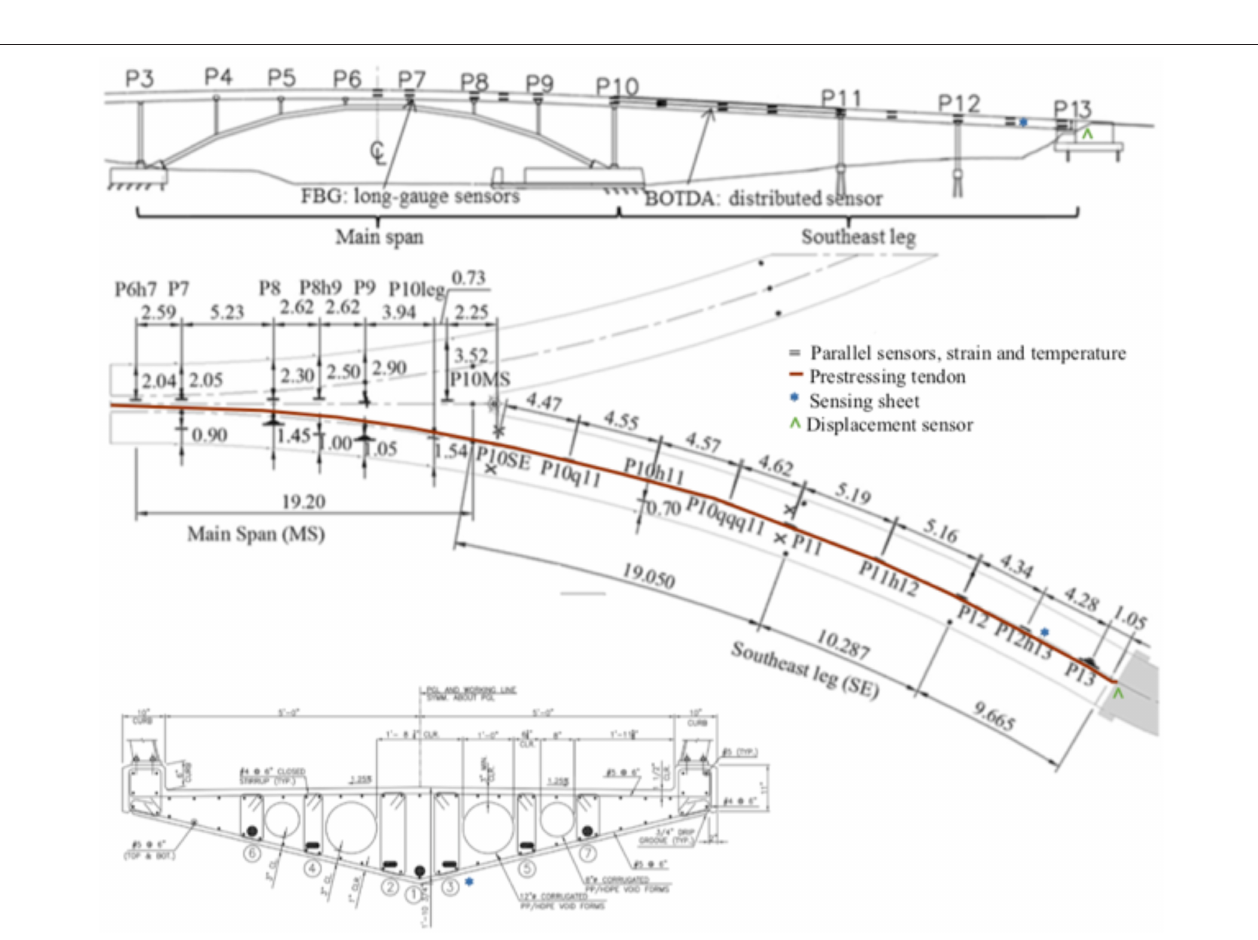
FIGURE 9 | Location of sensors on Streicker Bridge in plan and in section.